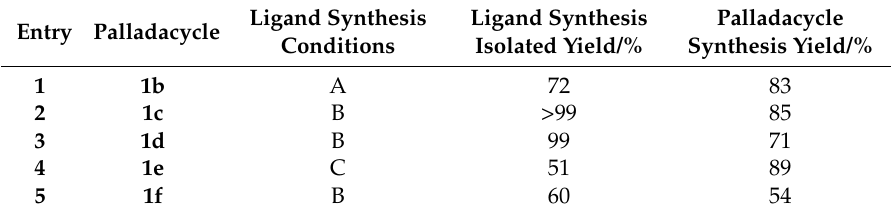
Table 1. SCN pincer palladacycle synthesis yields.